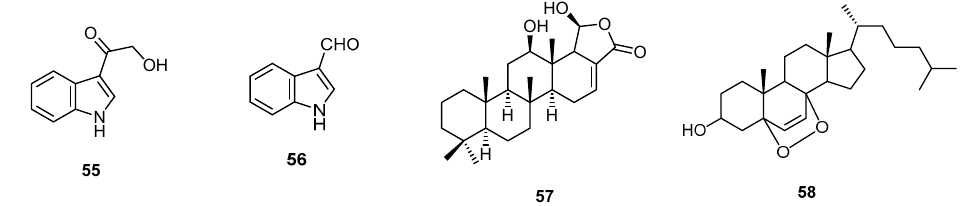
Figure 14. Chemical structures of deoxyhyrtiosine A ( 55 ), indole-3-carbaldehyde ( 56 ), 12- O -deacetyl-